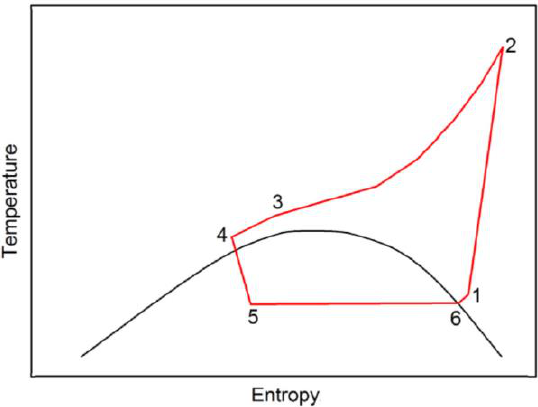
Figure 5. T – s diagram of transcritical vapor compression refrigeration cycle.